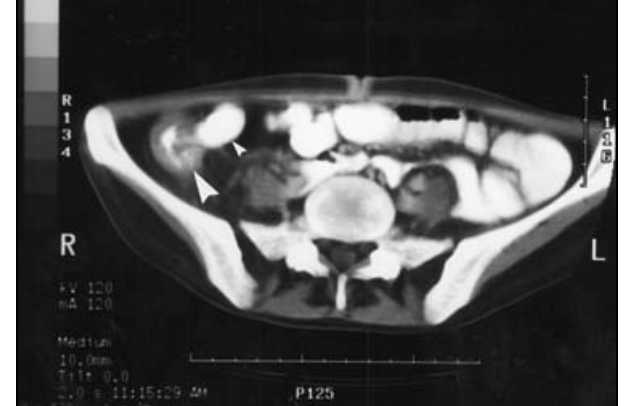
Figure 1) Computed tomography scan of the abdomen showing cir- cumferential uniform thickening of the wall of the bowel (arrow- heads)